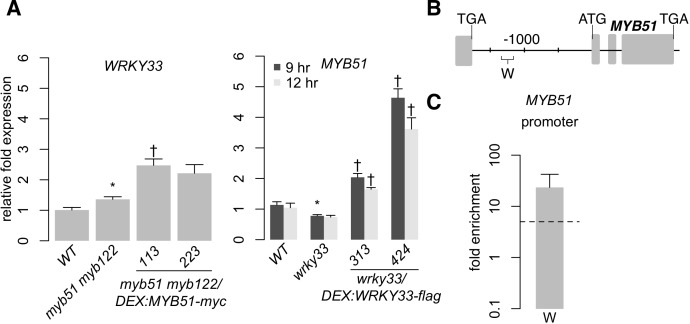
WRKY33 directly activates W-box–containing MYB51 promoter. (A) qPCR analysis of WRKY33 (left) and MYB51 (right) in 9-day-old seedlings co-elicited with 20 μM Dex and Psta for 12 h (left) or 9 and 12 h (right). Data represent the mean ± SE of four replicates of 13–17 seedlings each. Expression values were normalized to that of the housekeeping gene EIF4A1 and relative to those of WT plants. Asterisks and daggers denote statistically significant differences compared to wild-type and myb51 myb122 (left) or wrky33 (right) respectively (P < 0.05, two-tailed t test). Experiments were performed at least twice including in WRKY33-myc (Barco et al., 2019b), producing similar results. (B, C) Nucleotide positions (B) and ChIP-PCR analysis (C) of W-box–containing MYB51 promoter region W bound by WRKY33-flag in wrky33/DEX:WRKY33-flag plants co-elicited with 20 μM Dex or mock solution (0.5% DMSO) and Psta for 9 h. The WRKY33 promoter lacks SMRE motifs. Dashed line represents the fivefold cutoff between weak and strong TF–DNA interactions. Data in (C) represent median ± SE of four biological replicates, each containing approximately 200 seedlings. Experiments were performed twice, producing similar results.